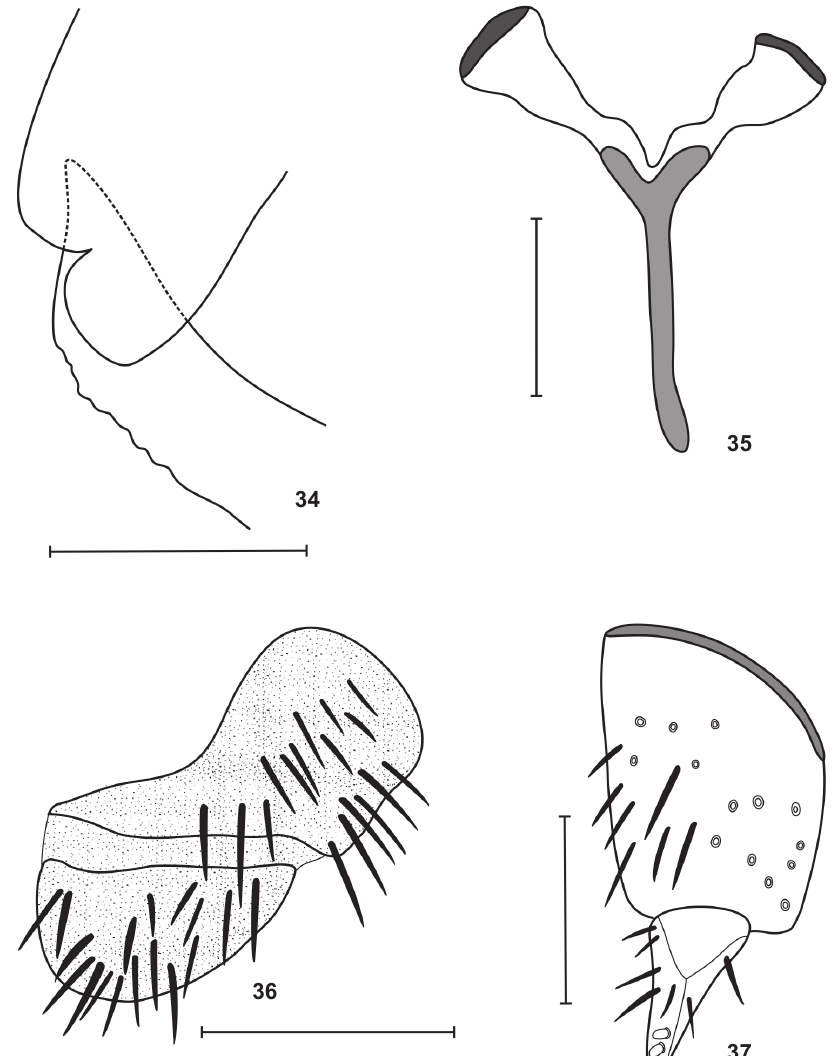
Figure 34-37. Adult of L. pernigrum : (34-36 female) (34) calcipala and pedisulcus; (35) genital fork; (36) cerci and paraproct. (37) male, gonocoxite and gonostylus. Bar: 0.1